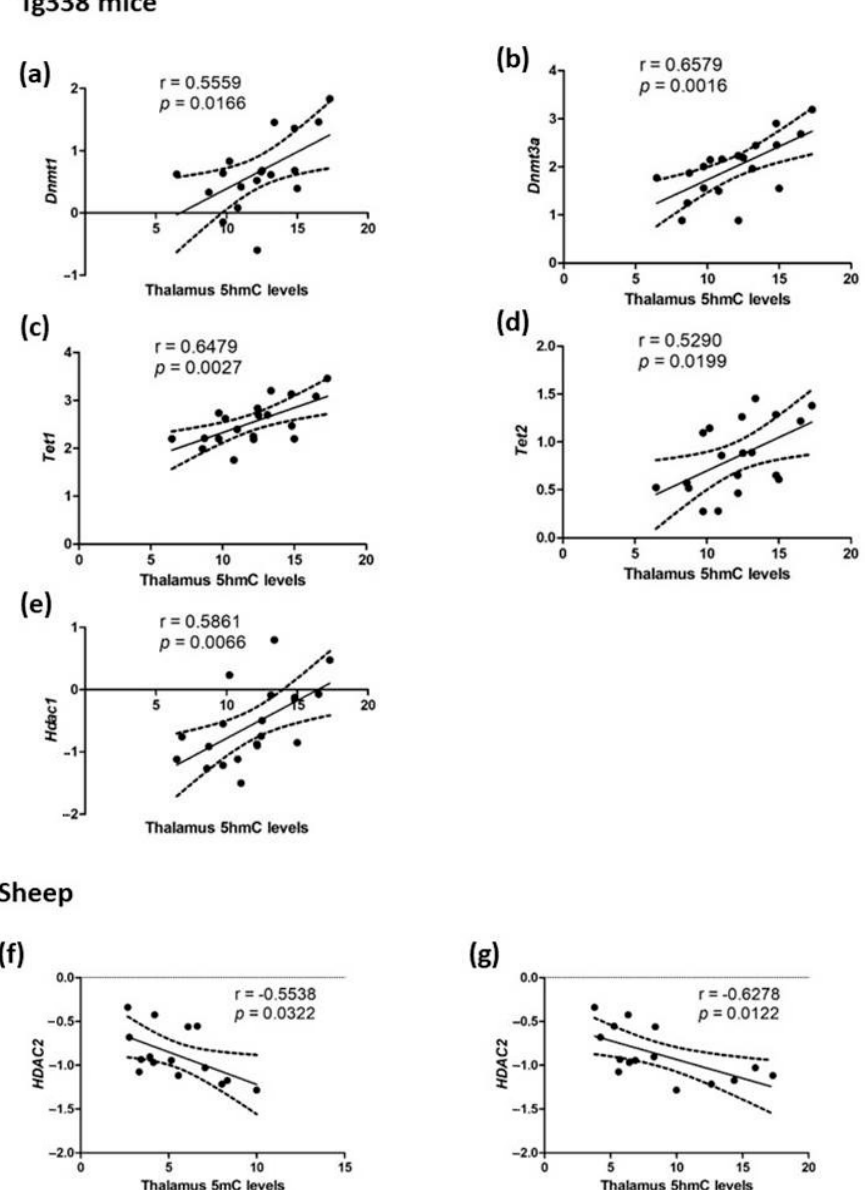
Figure 13. Correlations in the thalamus region of 5mC and 5hmC with the expression levels of some genes involved in epigenetic regulation. 5hmC positively correlated with ( a ) Dnmt1 , ( b ) Dnmt3a , ( c ) Tet1 , ( d ) Tet2 , and ( e ) Hdac1 in Tg338 mice, and 5mC ( f ) and 5hmC ( g ) negatively correlated with HDAC2 in sheep.